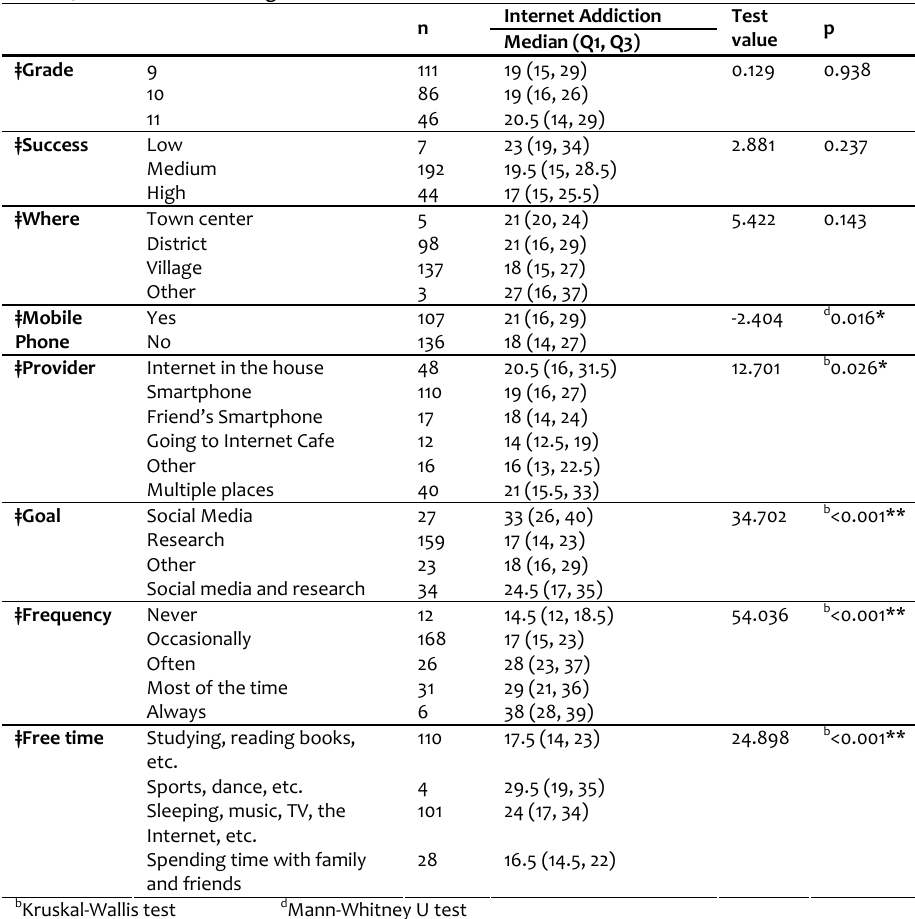
Table 4. Evaluations According to Internet